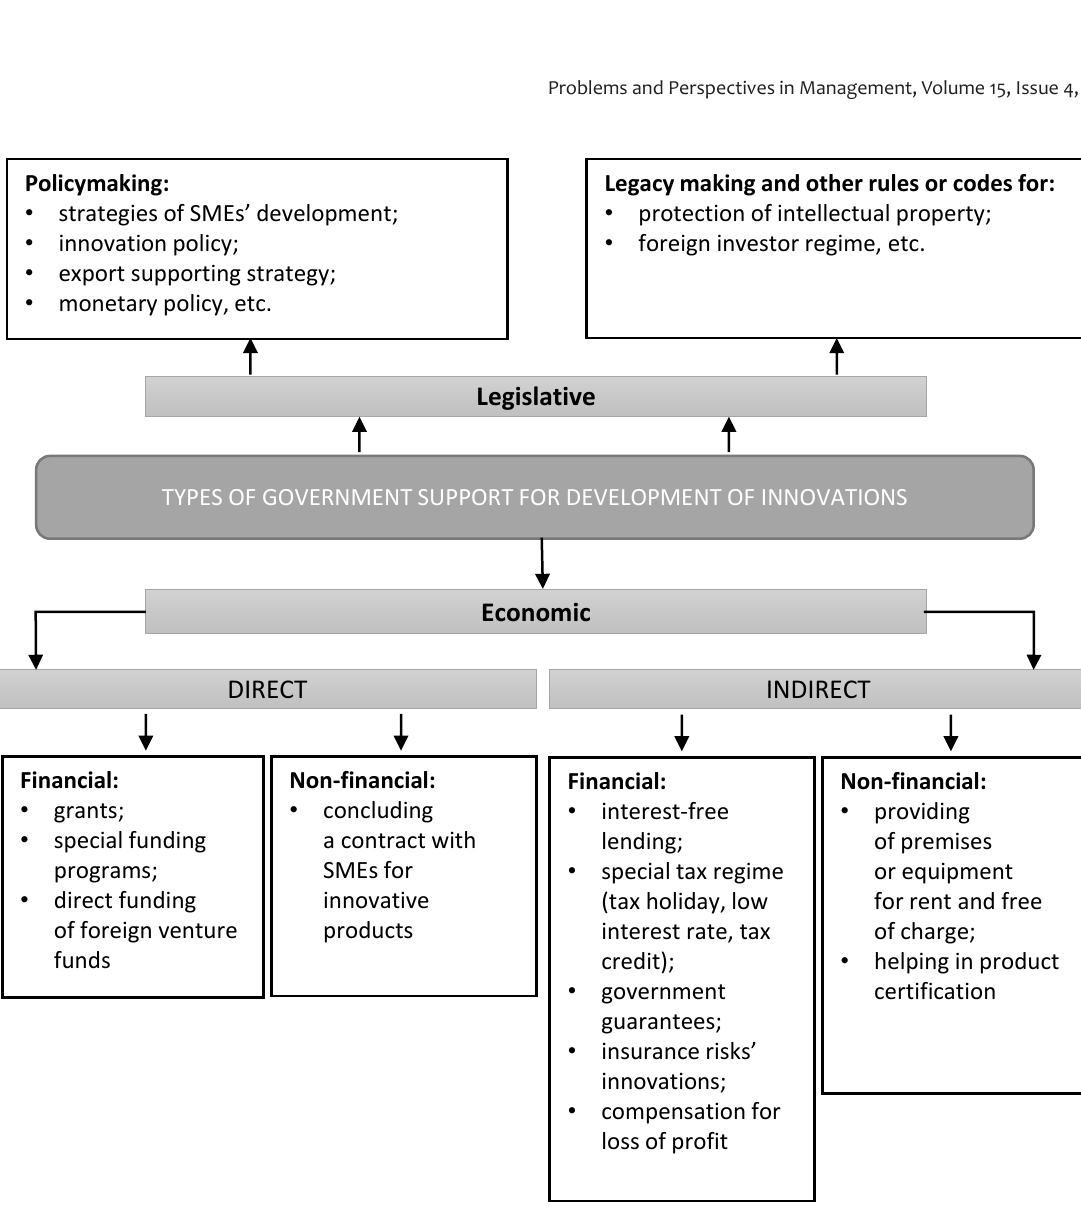
Figure 4. Types of government support for development of